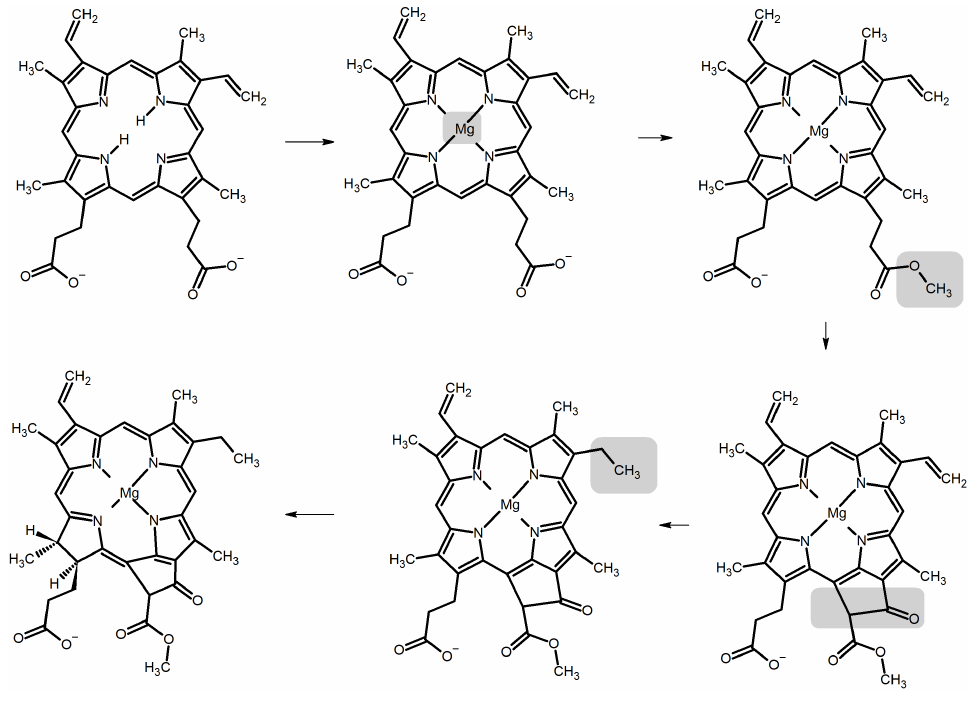
Figure 1 Biosynthetic pathway of chlorophyllide biosynthesis from protoporphyrin IX. Full-size DOI: